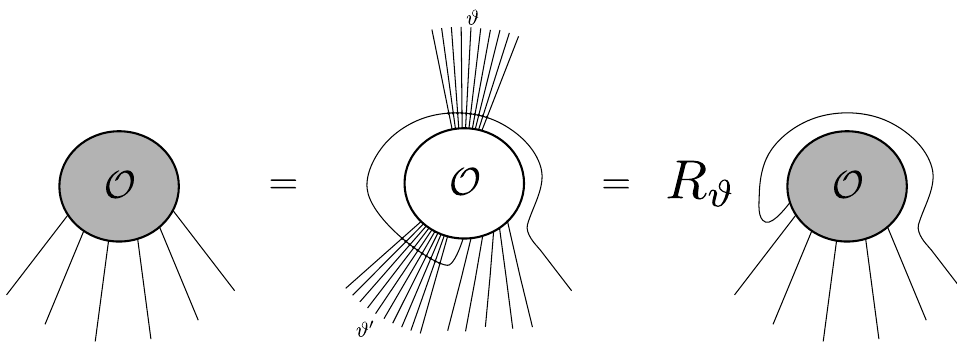
Figure 6. The periodicity axiom in the presence of the background is modi(cid:12)ed by an extra phase factor which depends on the background, the particle content and on the particle which is moved around. This extra phase factor comes from scattering of the particle going around with the background particles of the incoming and outgoing